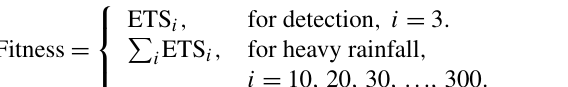
Figure 1. The flowchart of the µ-GA–WRF interface system.